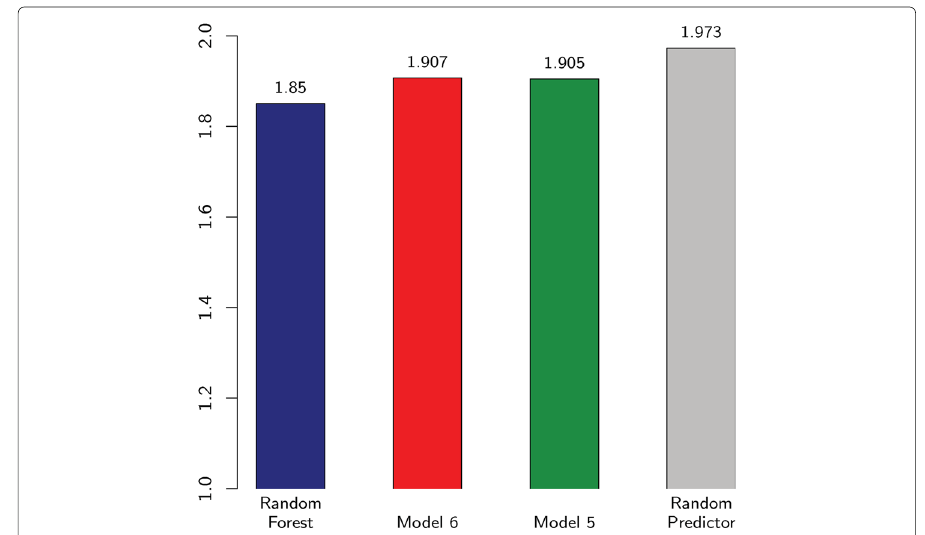
Fig. 4 Relative Root Mean Squared Error